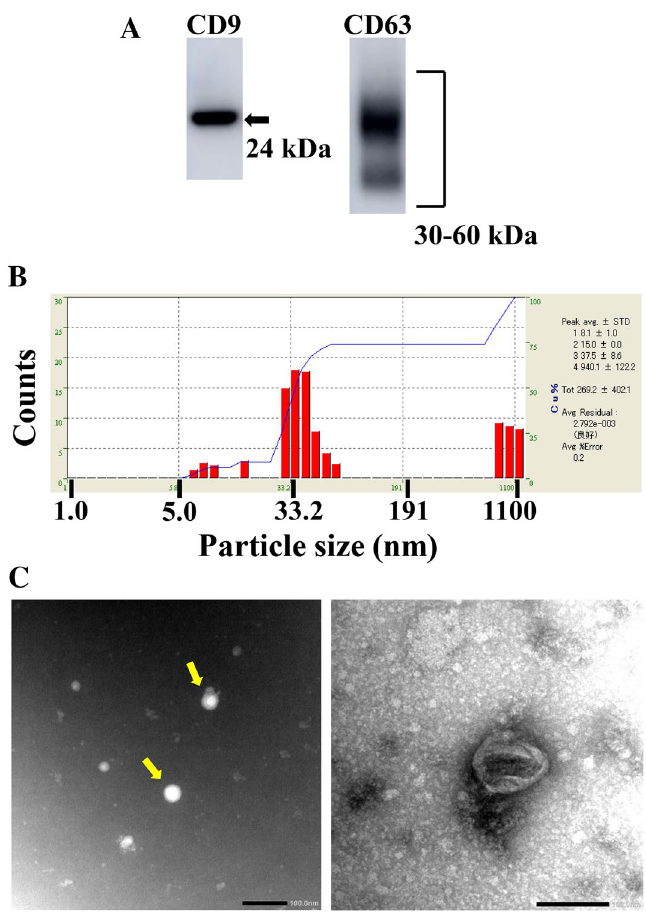
Figure 1. Confirmation of isolation of exosomes from human serum, using western blot analyses of CD9 and CD63 levels ( A ), size distribution ( B ), and morphology ( C ). Human serum-derived exosomes were isolated using a kit. ( A ) The lysate of the resulting exosome fraction was resolved by SDS-PAGE and electroblotted onto a PVDF membrane. The blot was probed with anti CD9- and CD63-antibodies, followed by a corresponding HRP-tagged secondary antibody. Data are representative of three experiments. Full-length blots are present in Supplemental Fig. 1. ( B ) Isolated exosomes were suspended in 100 µL PBS. The size of the exosomes was measured by dynamic light scattering. ( C ) The morphology of exosomes was examined by TEM. Scale bar = 100